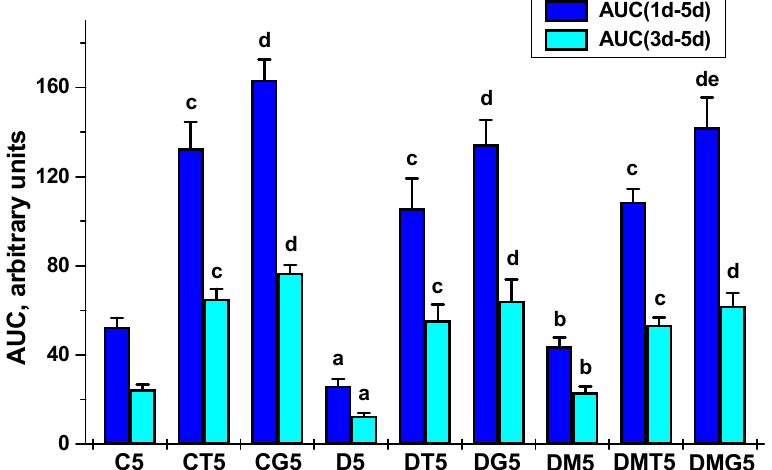
Figure 2. The AUC 1d-5d and AUC 3d-5d values for the curves “testosterone concentration (nM) vs. time (days)” in the control and diabetic animals, and the effects of five-week metformin treatment and five-day administration of TP3 and hCG. The AUC 1d-5d and AUC 3d-5d values are given for the curves “testosterone concentration (nM) vs. time (days)”, where 1–5 and 3–5 represent the intervals from the first to fifth days and from the third to fifth days of LH/hCG-R-agonists treatment, respectively. The duration of MF treatment (120 mg/kg/day) was five weeks, and the daily doses of TP3 and hCG were 15 mg/kg and 15 IU/rat, respectively. Five-day treatment with TP3 and hCG was carried out from the 31st to the 35th days of MF treatment. a —the difference between the C5 vs. D5; b —the difference between the D5 vs. DM5; c —the difference between the C5 vs. CT5, D5 vs. DT5 and DM5 vs. DMT5; d —the difference between the C5 vs. CG5, D5 vs. DG5 and DM5 vs. DMG5; and e —the difference between the DMT5 vs. DMG5 are significant at p < 0.05. The data are presented as the M ± SEM, n =